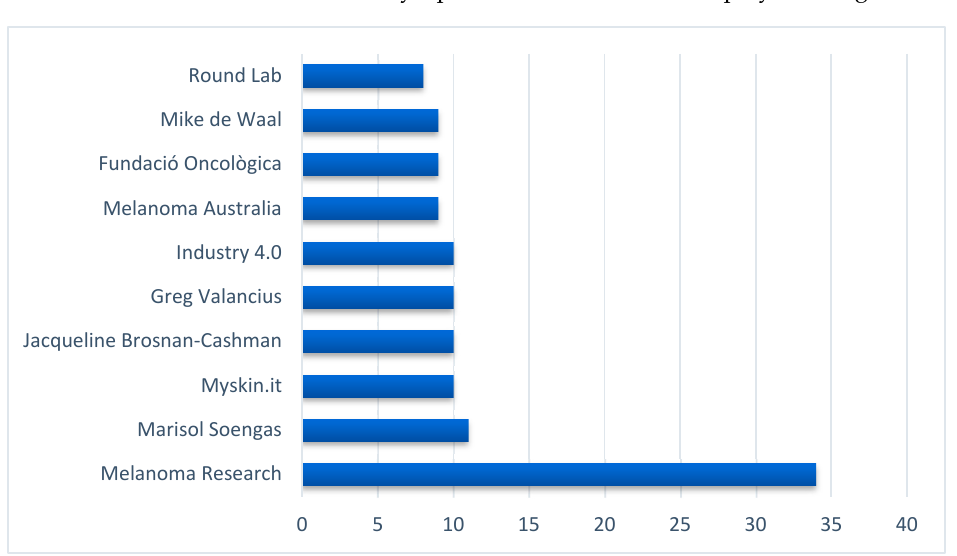
Figure 3. Top sources of melanoma-related information on Twitter ranked by the in-degree centrality scores.